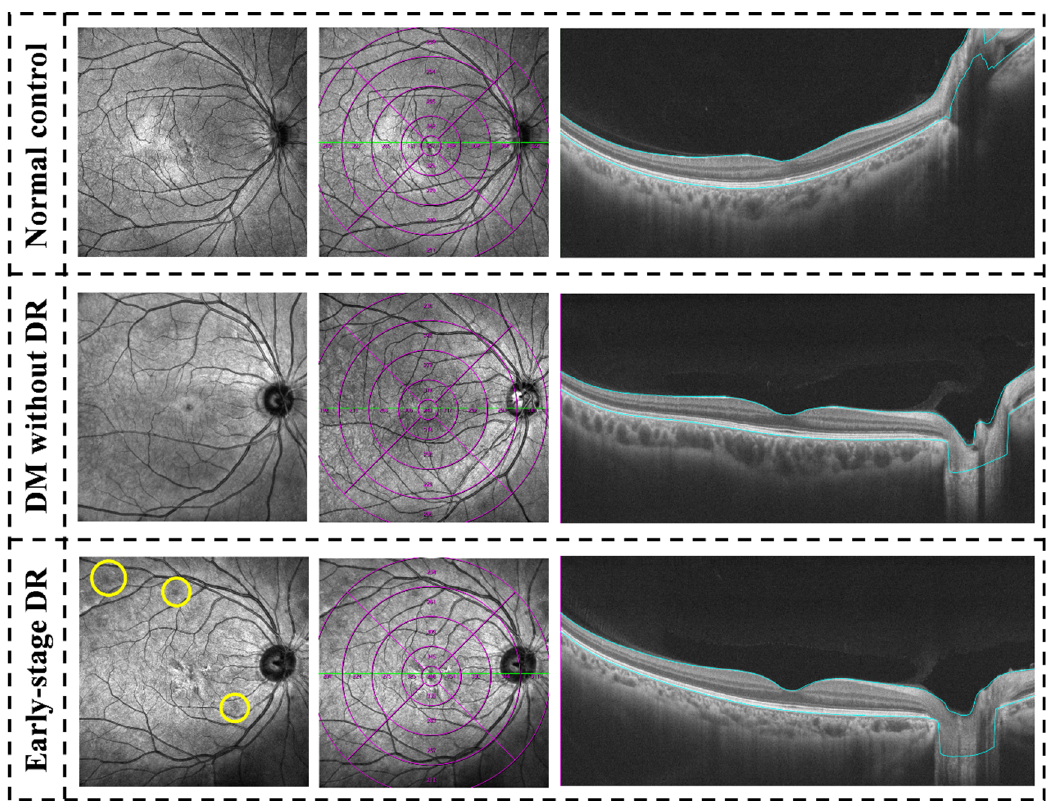
Figure 3. Examples of quantitative measurement of CMT using Wide-field optical coherence tomog- raphy in patients with early-stage diabetic retinopathy, diabetes mellitus without ophthalmoscopic signs of diabetic retinopathy and non-diabetic subjects of the control group. The left column was En face infrared photography (12 × 12 mm) images, the yellow circle at the lower left showed fundus hemorrhage of early-stage DR. The following columns were quantitative measurements of the whole area (diameter of 12 mm) and in concentric rings with different radii (0–3, 3–6, 6–9, and 9–12 mm) of CMT. CMT, central macular thickness.